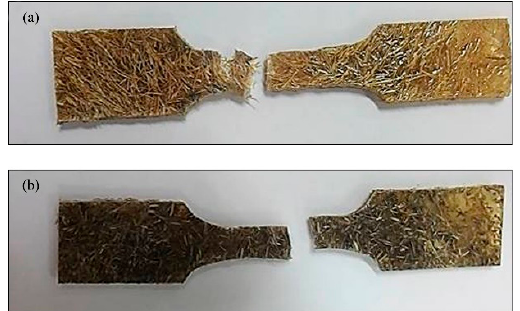
Figure 6. Specimens after tensile testing: ( a ) r-EPS/5% t-coir, and ( b ) r-EPS/5% t-BSF.